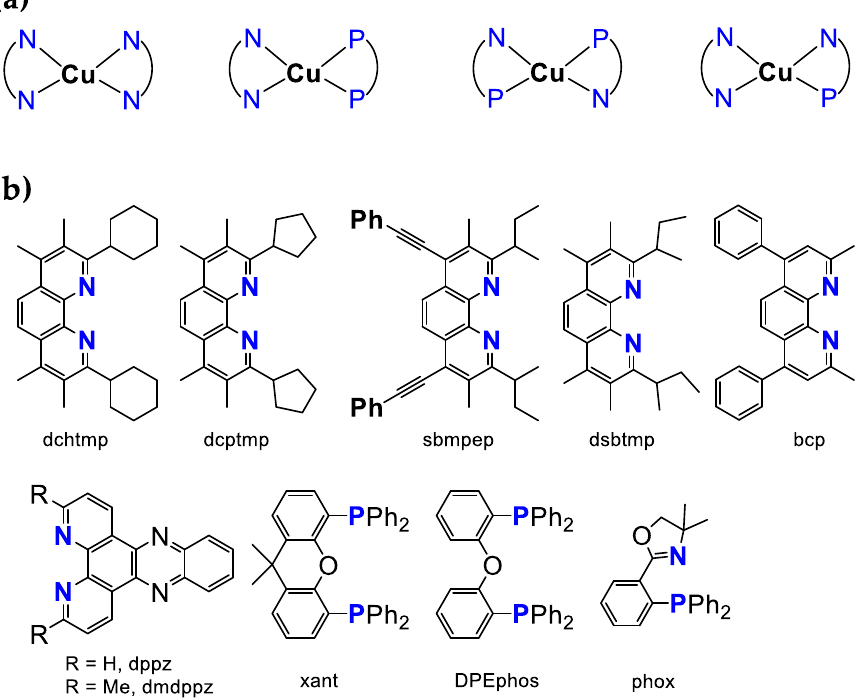
Figure 10. Chemical structures of the ( a ) Cu-based photosensitizers and ( b ) corresponding ligands in this review.